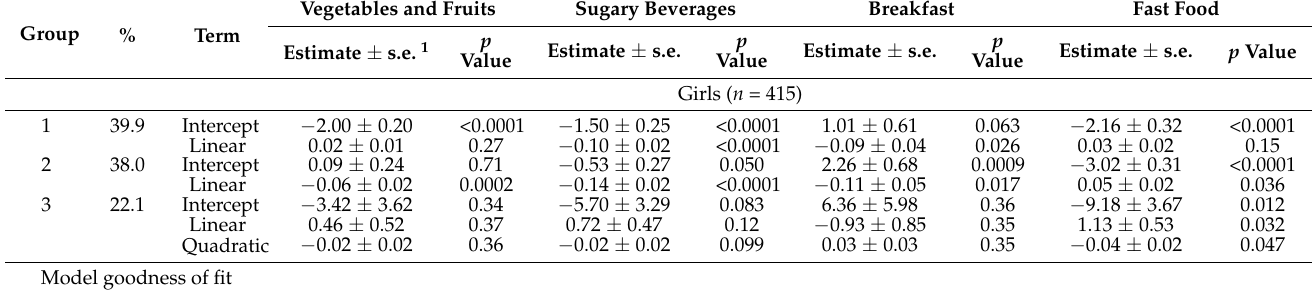
Table 2. The estimated group-specific trajectory regression coefficients for the group-based multi-trajectory model ( n = 744). Group %